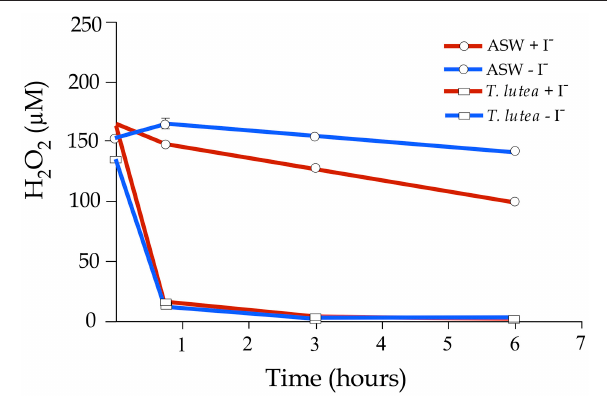
FIGURE 5 | Hydrogen peroxide decomposition in artificial seawater (ASW) and in an exponential culture of T. lutea . Half of the samples were added iodide (500 µ M) and then all samples were treated with H 2 O 2 (200 µ M). H 2 O 2 levels were monitored for 6h. Bars represent mean values ± SEM ( n = 4). Red lines indicated iodide-added samples and blue lines the controls without